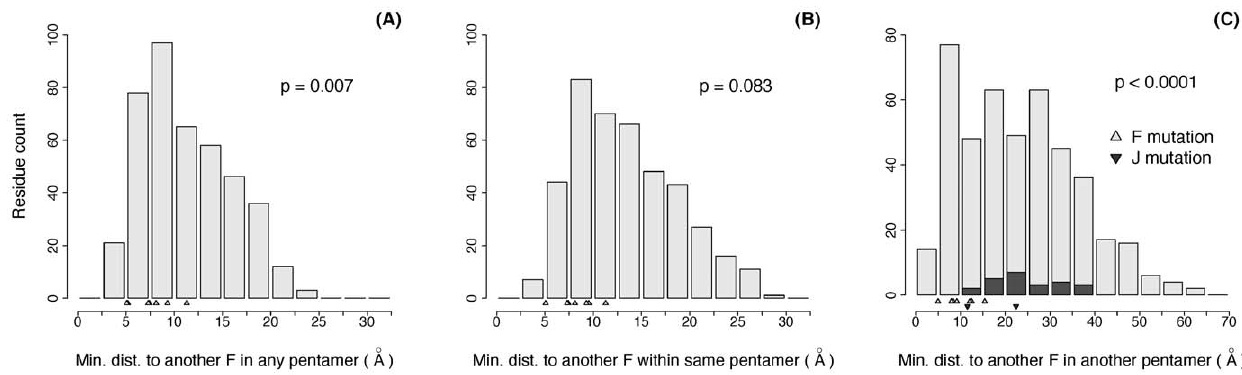
Figure 6. Distances from F and J residues to nearest adjacent F protein. For each residue in F (light grey) and J (dark grey), the distance between its alpha carbon and the alpha carbon of every residue in all adjacent F proteins was calculated. Distributions were calculated using the minimum distances to adjacent F proteins (A) in any pentamer, (B) in the same pentamer, or (C) in a different pentamer. Observed mutations are shown as triangles. P-values were calculated by simulating 10,000 datasets (each containing 8 random F and 2 random J mutations), taking the mean of their minimum distances as defined in each panel, and asking what proportion of random datasets had smaller means than the mean of the observed dataset. Note that J mutations are excluded from the distance calculations for (A) any pentamer and (B) the same pentamer because J is not present during intra-pentamer assembly.